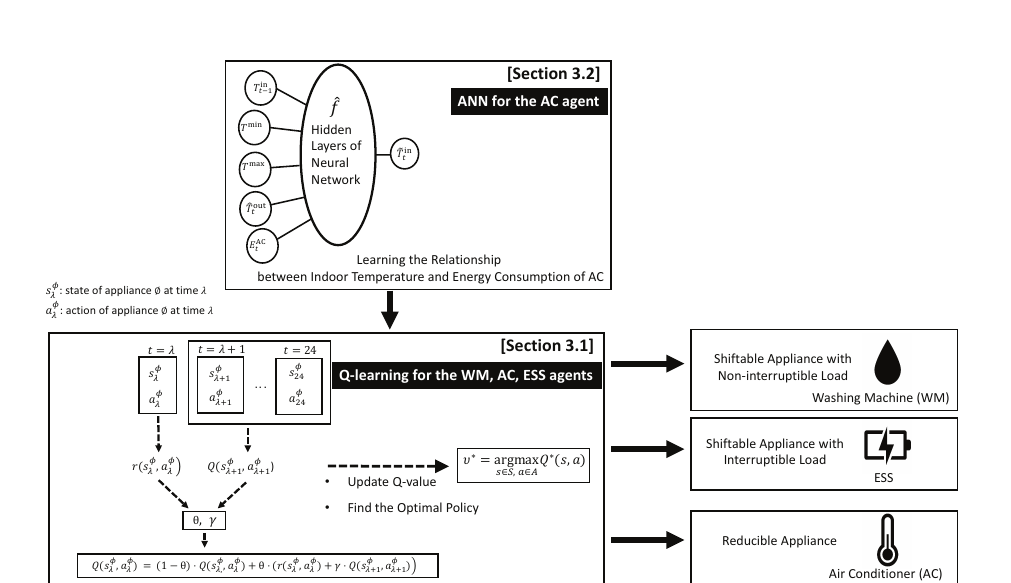
Figure 4. Overall architecture of the proposed HEMS algorithm using Q-learning and